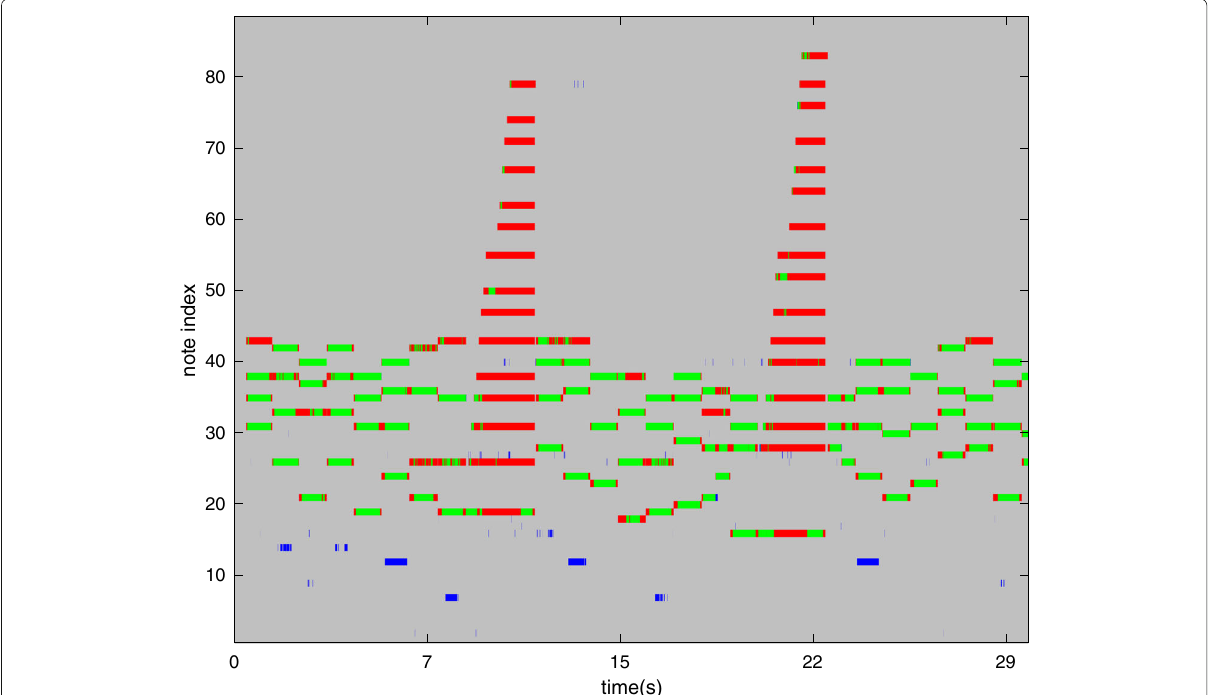
Fig. 14 AMT results of the first 30 s of “MAPS_MUS-bk_xmas5_ENSTDkCl” produced by plain MPENet, where green indicates true positives, red indicates false negatives and blue indicates false positives. A typical case of false positives is extra note detection in some chords. A typical case of false negatives is where more than 7 notes are active simultaneously (MPENet can detect the attacks, but not the